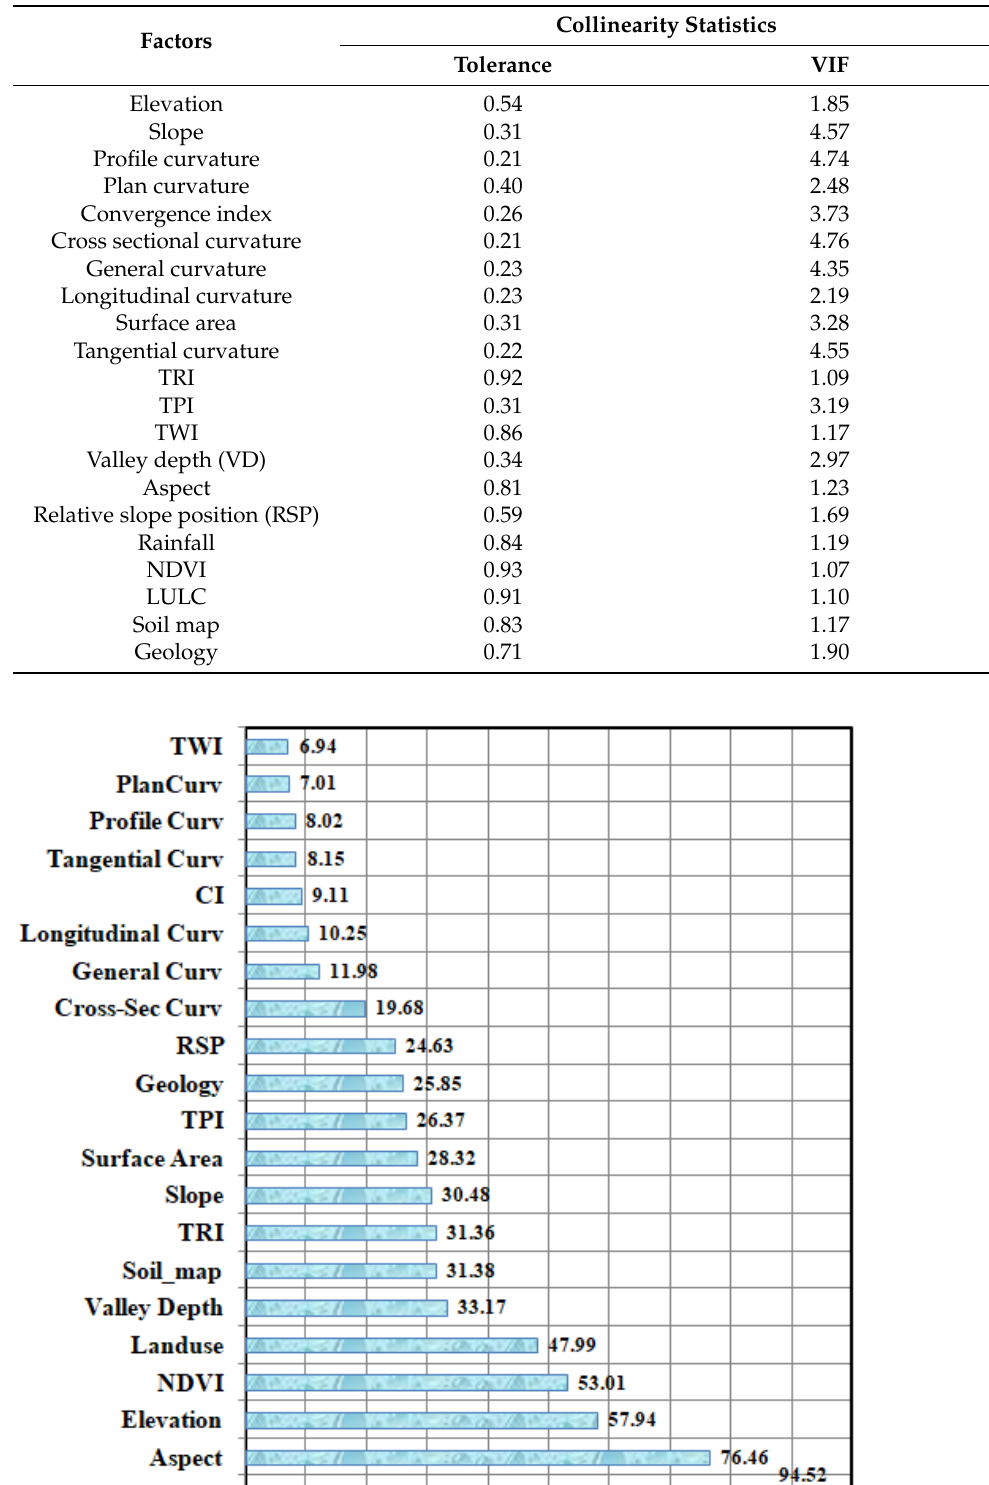
Table 4. Collinearity statistics of LCFs.